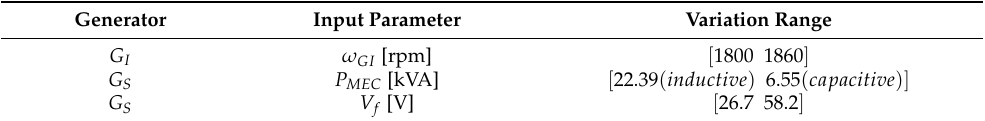
Table 2. Variation range of input parameters.